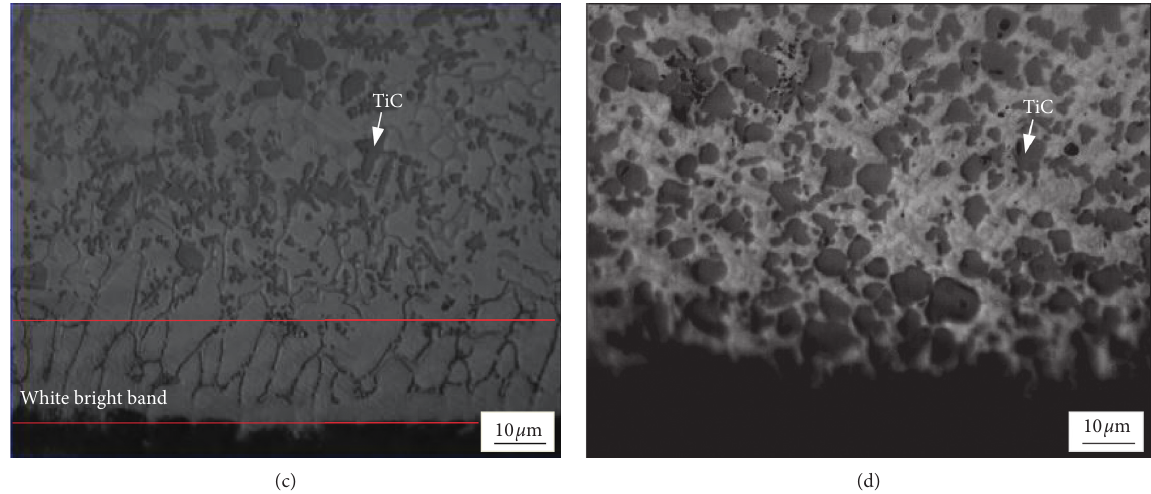
Figure 4: Microstructure of cross section of the coatings after LC process. (a) S0 coating. (b) S1 coating. (c) S2 coating. (d) S3